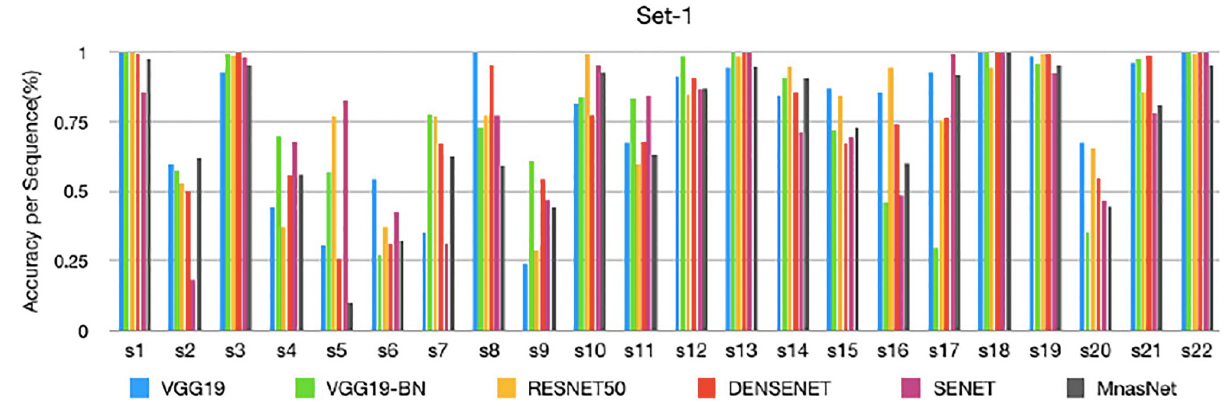
Fig 5. Sequence-based performance of set-1: The performance of different models for each test sequence of set-1.